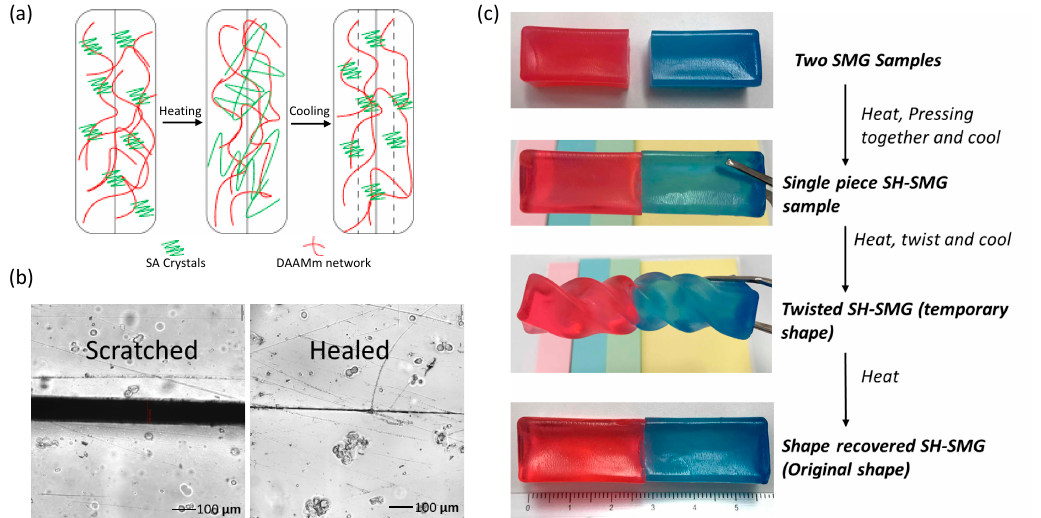
Figure 3. ( a ) Illustration of the self-healing mechanism, ( b ) micrographs of scratched and healed surface, and ( c ) demonstration of self-healing and shape memory characteristics.